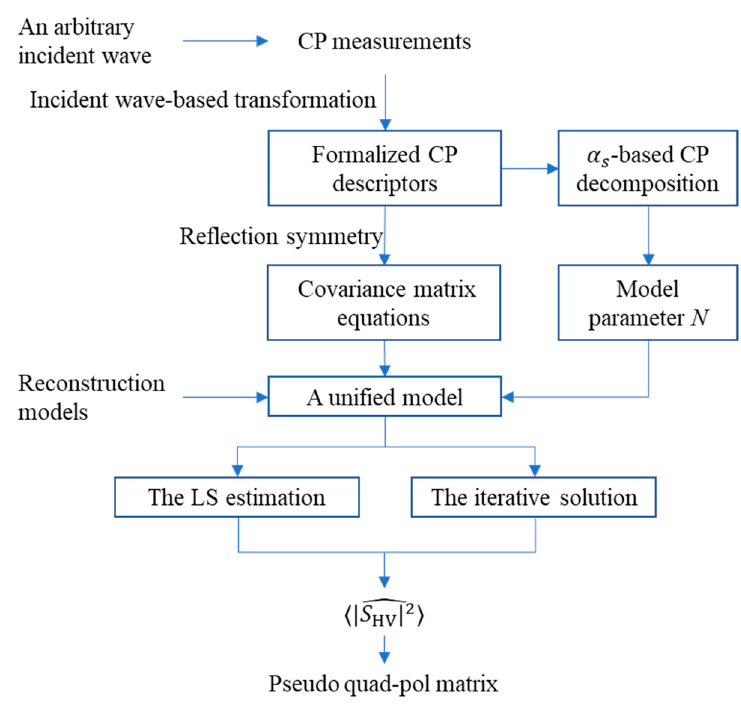
Figure 1. Outline of the study.